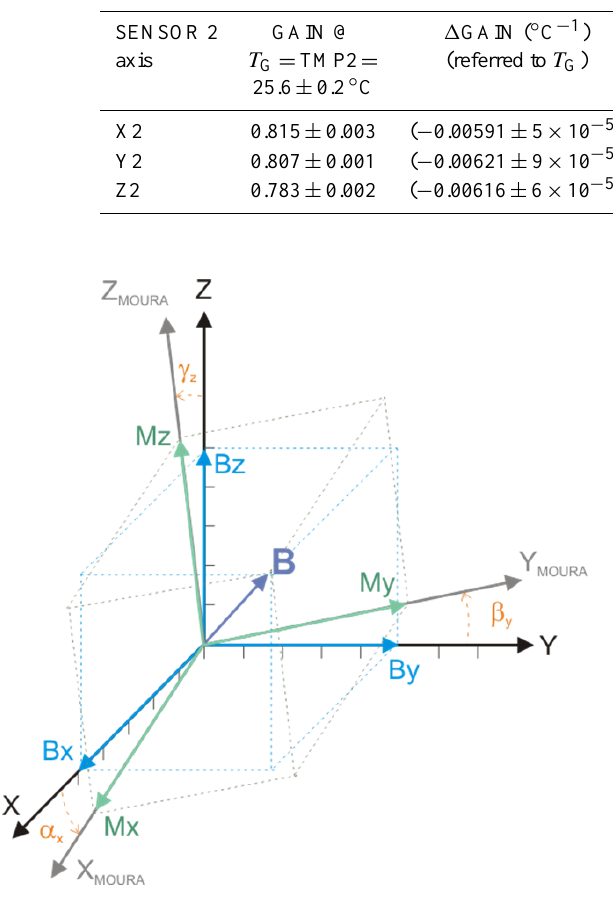
Figure 4. Approximation of system of reference of MOURA vs. ex- ternal system of reference with the approximations taken into ac-